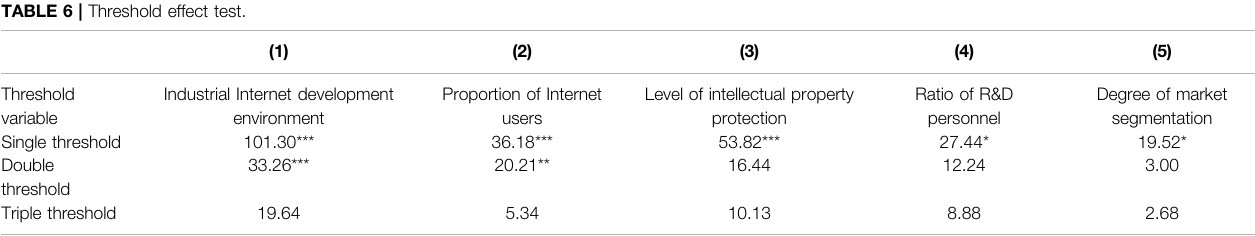
TABLE 6 | Threshold effect